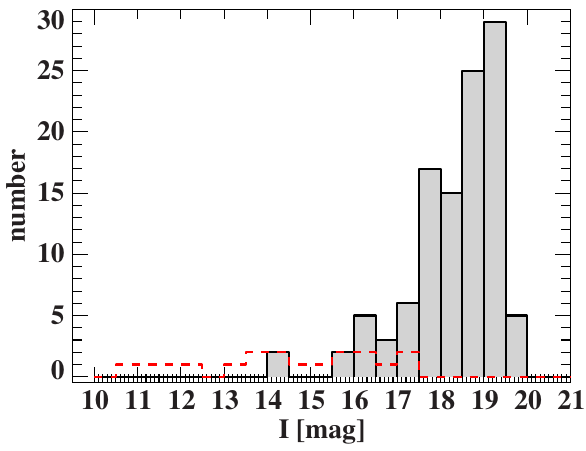
Figure 3. Magnitude distribution of the OGLE HW Vir candidates in comparison to the known HW Vir systems. The OGLE systems are shown in gray and the known systems by the red dashed line.